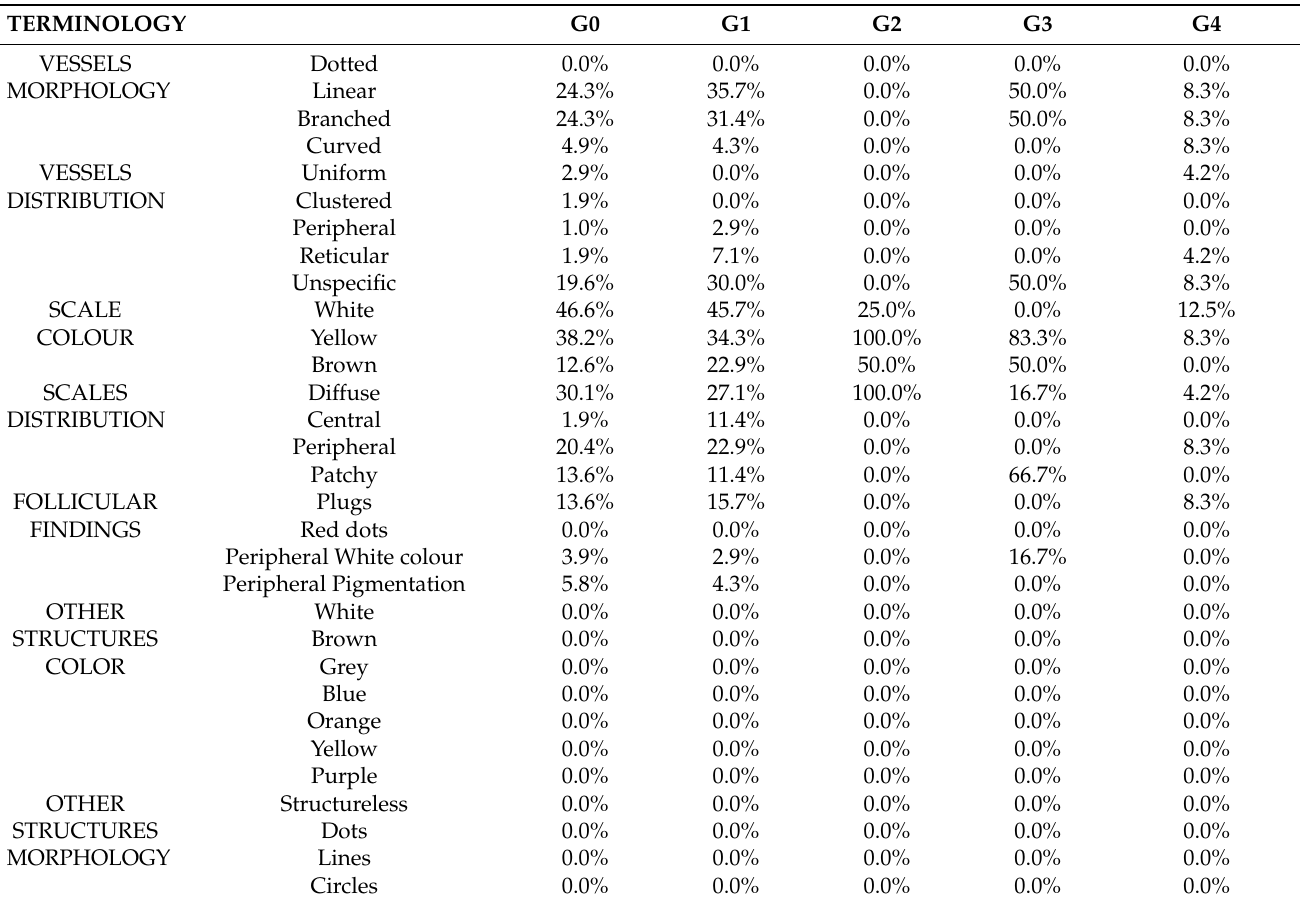
Table 6. Percentage occurrence of dermoscopic non-neoplastic features [6] depending on grade of radiodermatitis according to RTOG/EORTC